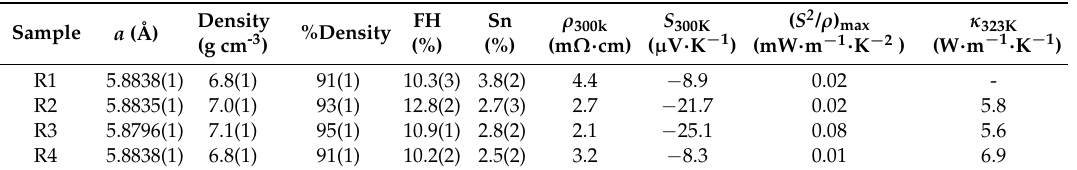
Table 2. Overview of the lattice parameters ( a ), sample densities, 300 K electrical resistivity ( ρ ) and Seebeck coefficient ( S ), maximum power factor ( S 2 / ρ ) max , and 323 K thermal conductivity ( κ ) for